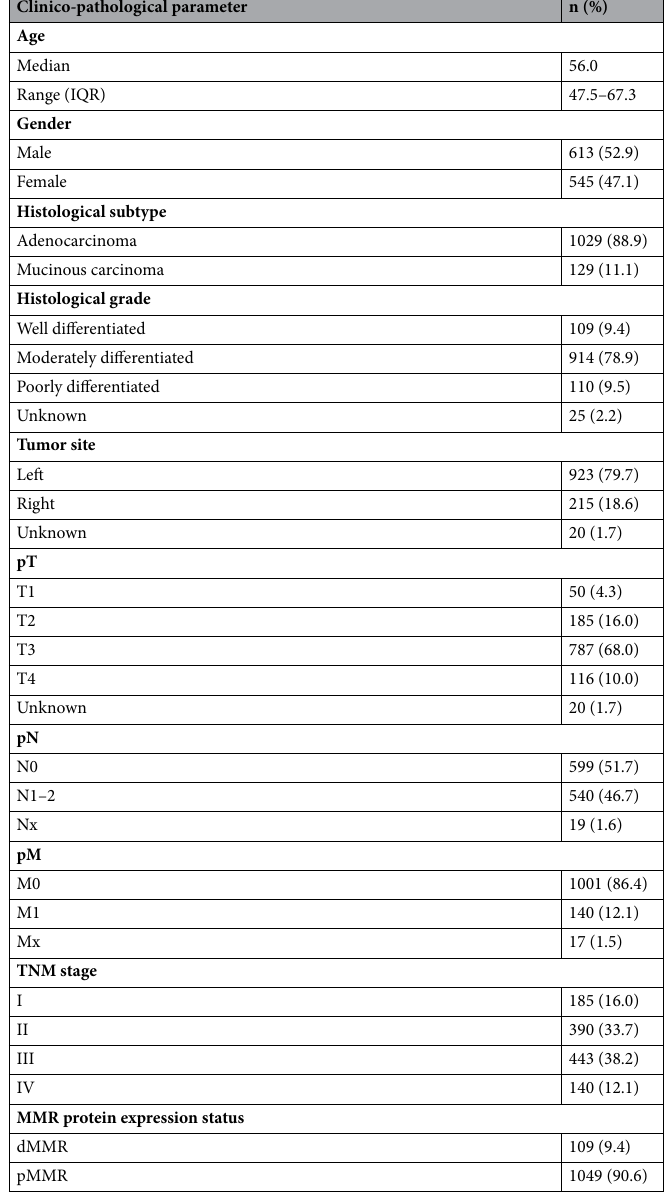
Table 1. Clinicopathological variables for the patient cohort (n = 1158). IQR inter quartile range, dMMR deficient mismatch repair, pMMR proficient mismatch